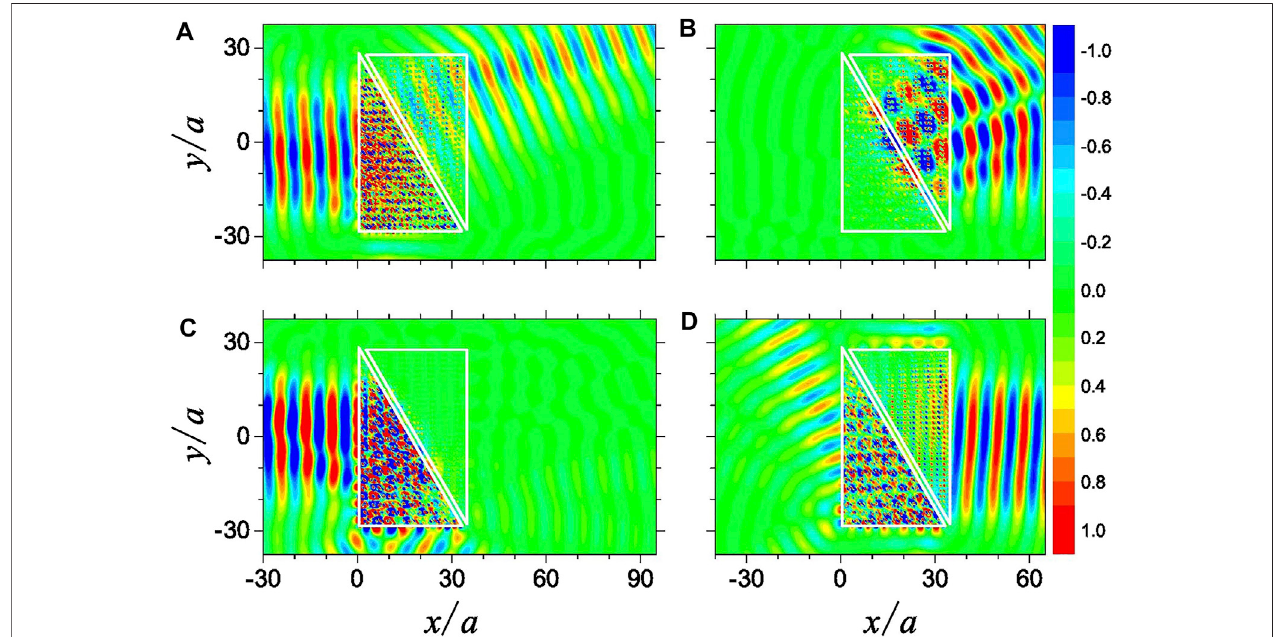
FIGURE 6 | Electric fi eld patterns illustrating the recon fi gurable unidirectional propagation by the second kind of HSMM made up of the EZI and EPI with the LHS incidenceexhibitingthe “ passing ” state (A) ,but the RHSincidence exhibiting total re fl ection (B) .By increasingthe BMF from H 2 0 (cid:1) 480Oeto H 1 0 (cid:1) 497Oe,theHSMMis transformedintothatmadeupoftheEZIandENI;thus,the “ RHSpassing ” statecanbeobservedfromthe fi eldpatternsinpanels (C,D) .FortheleftpartoftheHSMM,the lattice separation is ~ a 2 (cid:1) 12 . 25 mm and the rod radius is ~ r 2 (cid:1) 3 . 58 mm, and for the right part of the HSMM, the lattice separation is ~ a 1 (cid:1) 14 . 55 mm and the rod radius is ~ r 1 (cid:1) 3 . 78 mm. The operating frequency is f = 2.5 GHz, kept